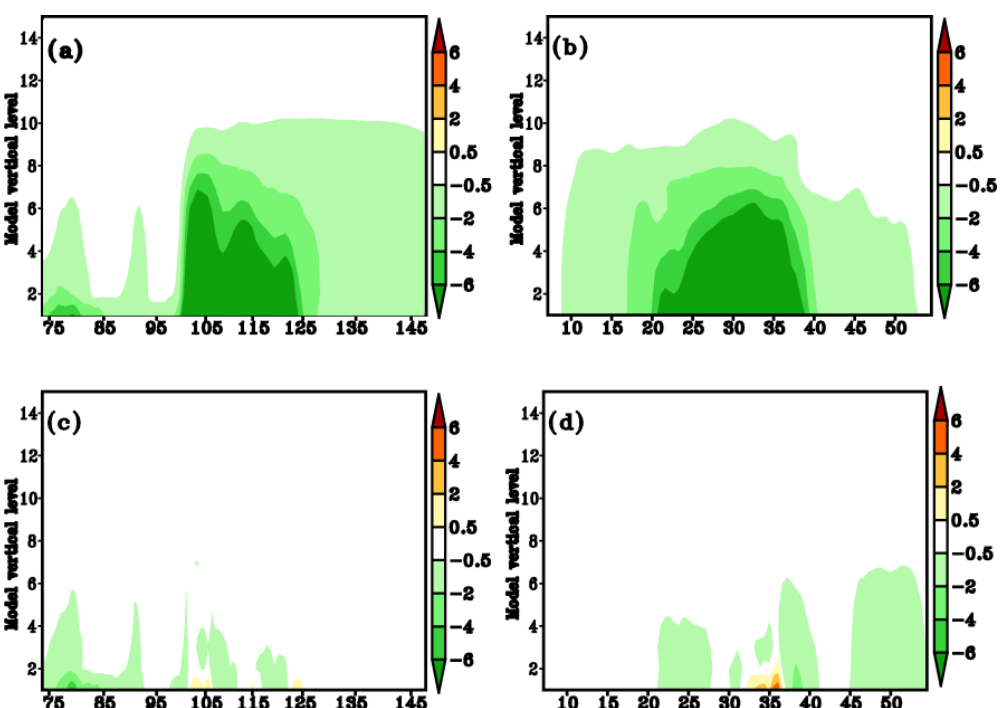
Figure 5. Monthly mean cross sections of C p t − C f t along line (a) EF and (b) GH, and monthly mean cross sections of C p t − C a t along line (c) EF and (d) GH (cross section lines shown in Fig. 4d) in February